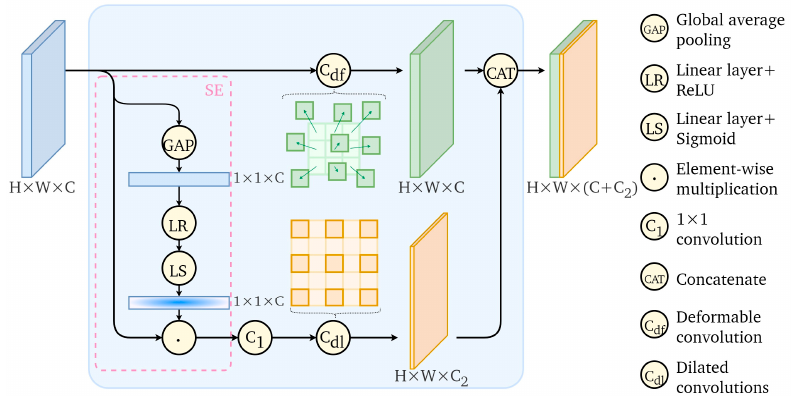
Figure 4. Structure diagram of the SFR module. Deformable convolution and dilated convolution expand the receptive field.